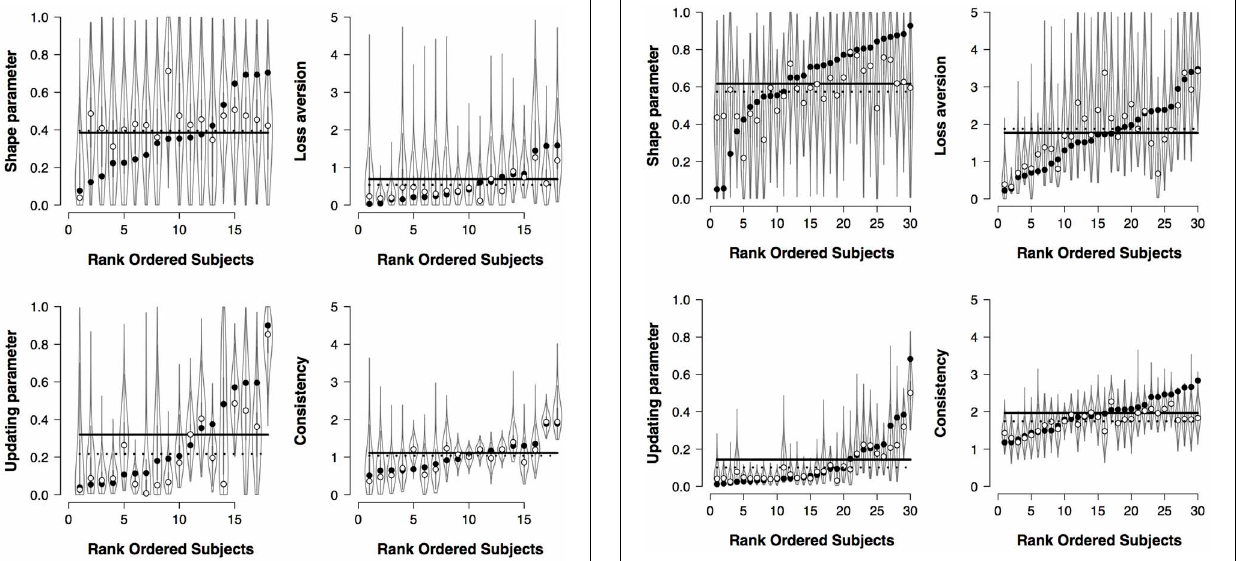
FIGURE A3 | Recovery of individual and group-level parameters of the PVL-Delta model. Data of 18 participants completing a 100-trial IGT. The dotted lines represent the modes of the group-level posteriors and the unfilled dots the modes of the group-level posterior.